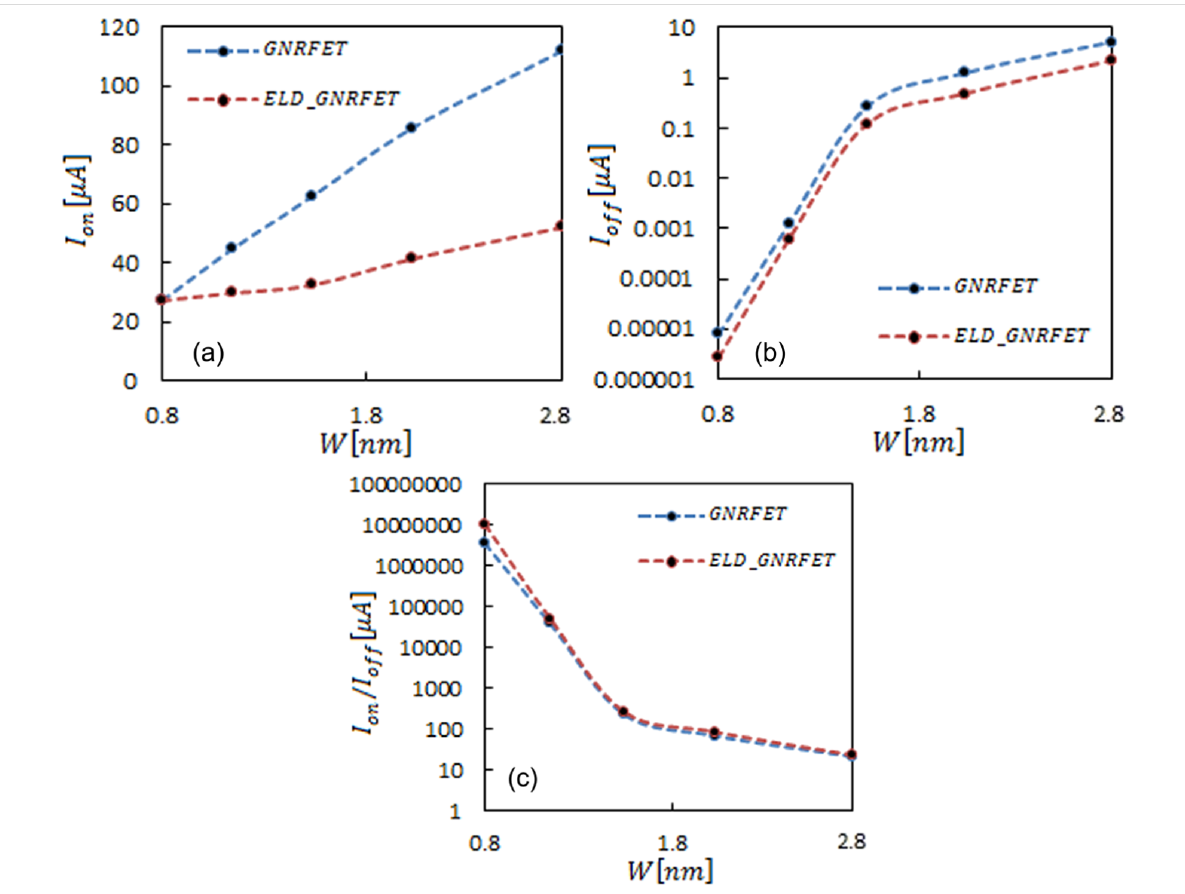
Figure 5: Channel width dependence of (a) on-current (b) off current (c) on/off current. The lines are a guide to the eye. The dashed blue line is for ELD-GNRFET and the dashed red line is for GNRFET.